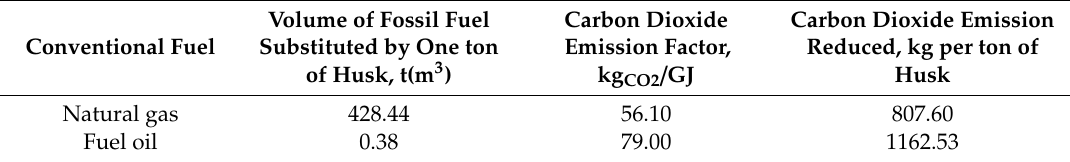
Table 2. Ecological impact of husk utilization.